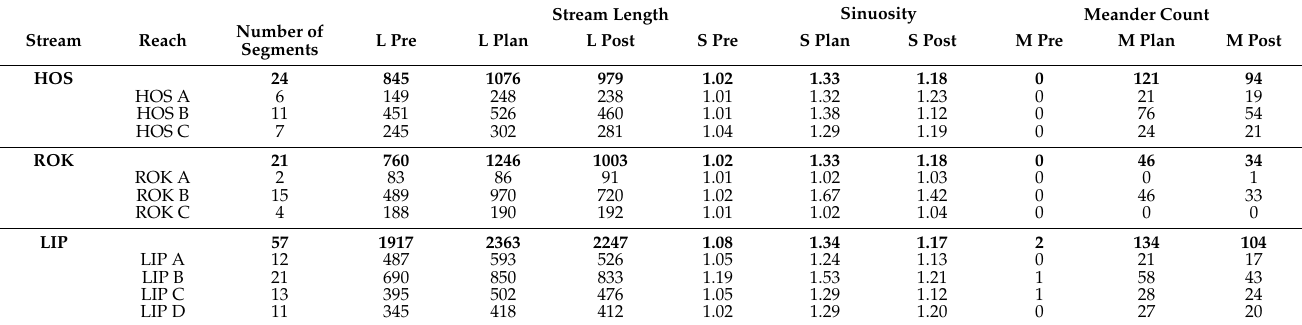
Table A1. Stream geometry characteristics by stream and reach.